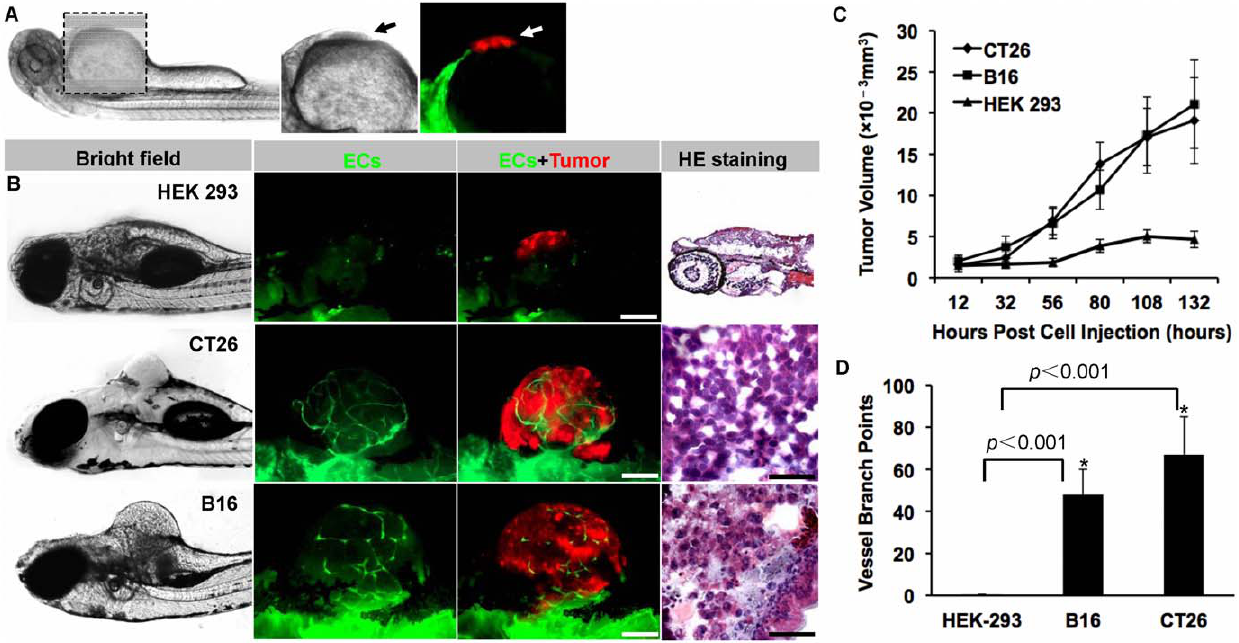
Figure 1. The establishment of mammalian tumor xenograft models in zebrafish. Red fluorescence-labeled malignant tumor cells (murine colon carcinoma CT26 and melanoma B16 cells) and non-tumorigenic HEK 293 cells were implanted into the abdominal perivitelline space (A, indicated by arrow) of 48 hpf Tg(flk1:EGFP) transgenic zebrafish embryos (50–100 cells/embryo). When tumors (B, red) reached 350–450 m m in diameter when filled with neo-vessels (B, green), the neoplasia were isolated and analyzed by H&E staining (B). The growth rate of xenografted tumors (C) and the number of tumor-induced neovessels (D) were analyzed quantitatively. * indicates the significant difference. Scale bar, 100 m m.